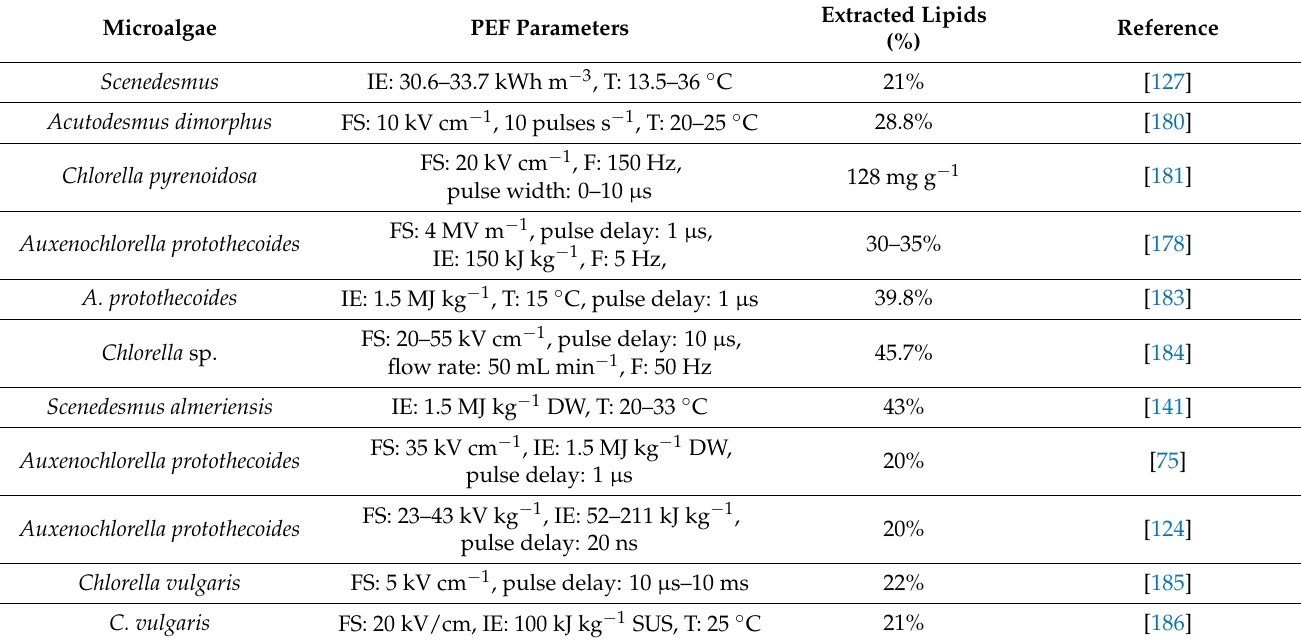
Table 7. Effect of the parameter variation of PEF on lipid extraction. DW: dry weight; T: